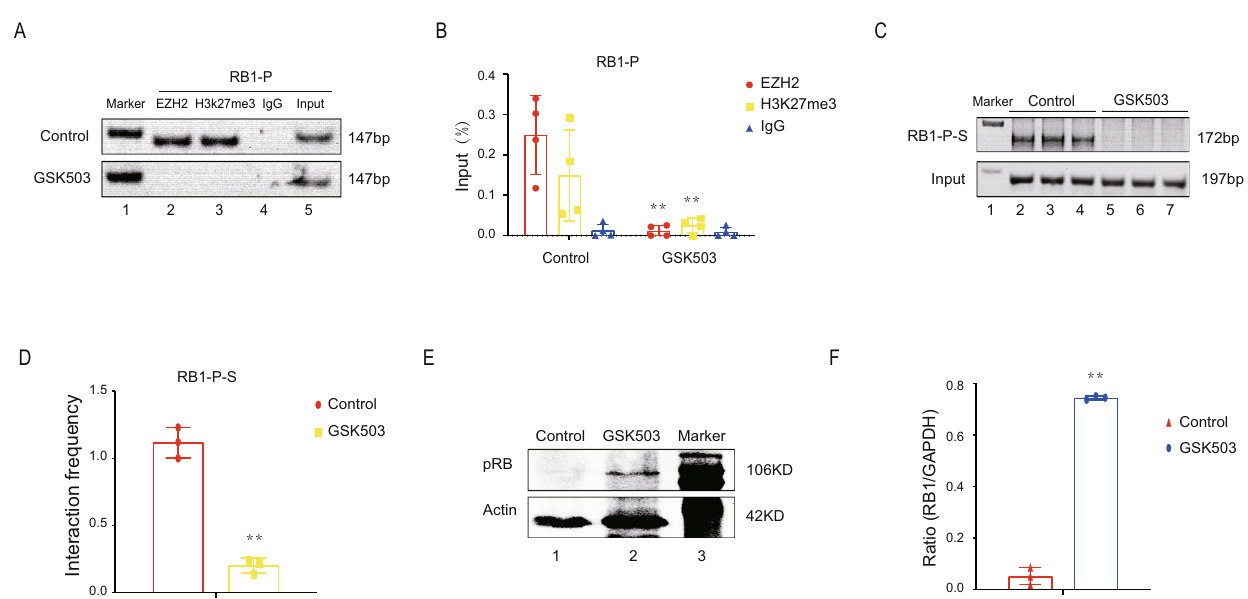
Fig. 5 GSK503 interrupts the chromosomal looping and restores pRB expression. A , B ChIP assay of the binding of EZH2 to the RB1 promoter (site E5) and the level of H3K27me3 after GSK503 treatment. ** P < 0.01. C , D 3C assay of the RB1-P-S chromosomal loop after GSK503 treatment. ** P < 0.01. E , F Western blot of pRB expression after GSK503 treatment. ** P <